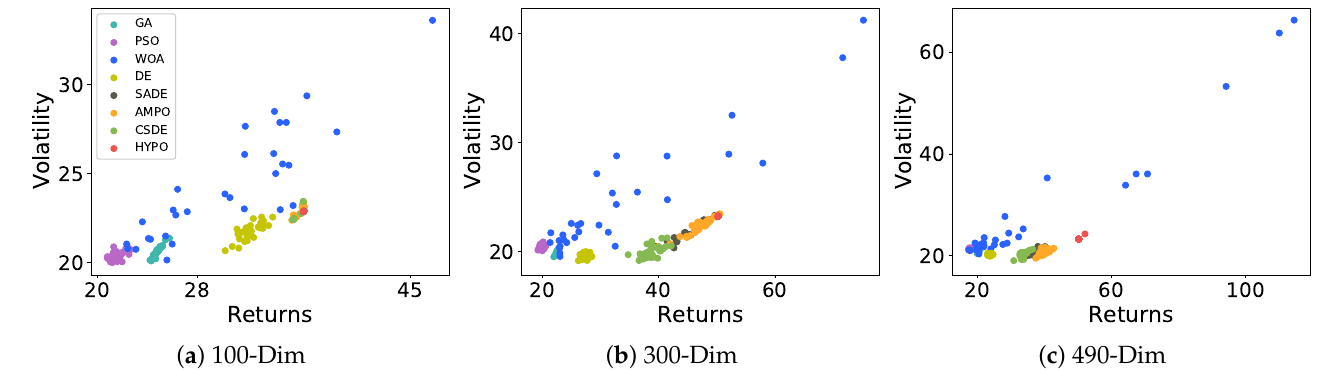
Figure 6. Visualization of Mean-variance Distribution on the SP500